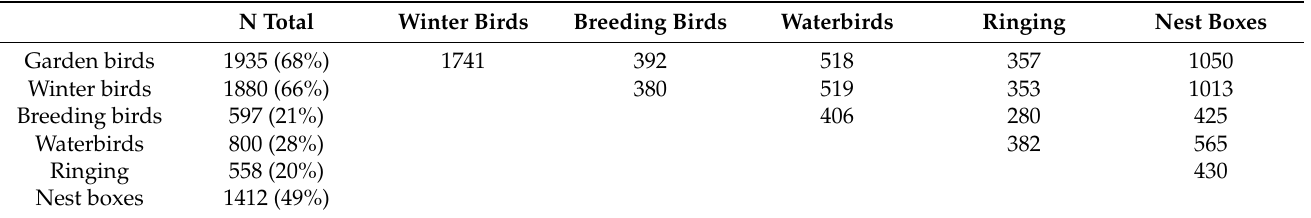
Table 1. Participation in different CS programs. The first column shows the total number of partici- pants. The following columns show the combination of programs combined by the